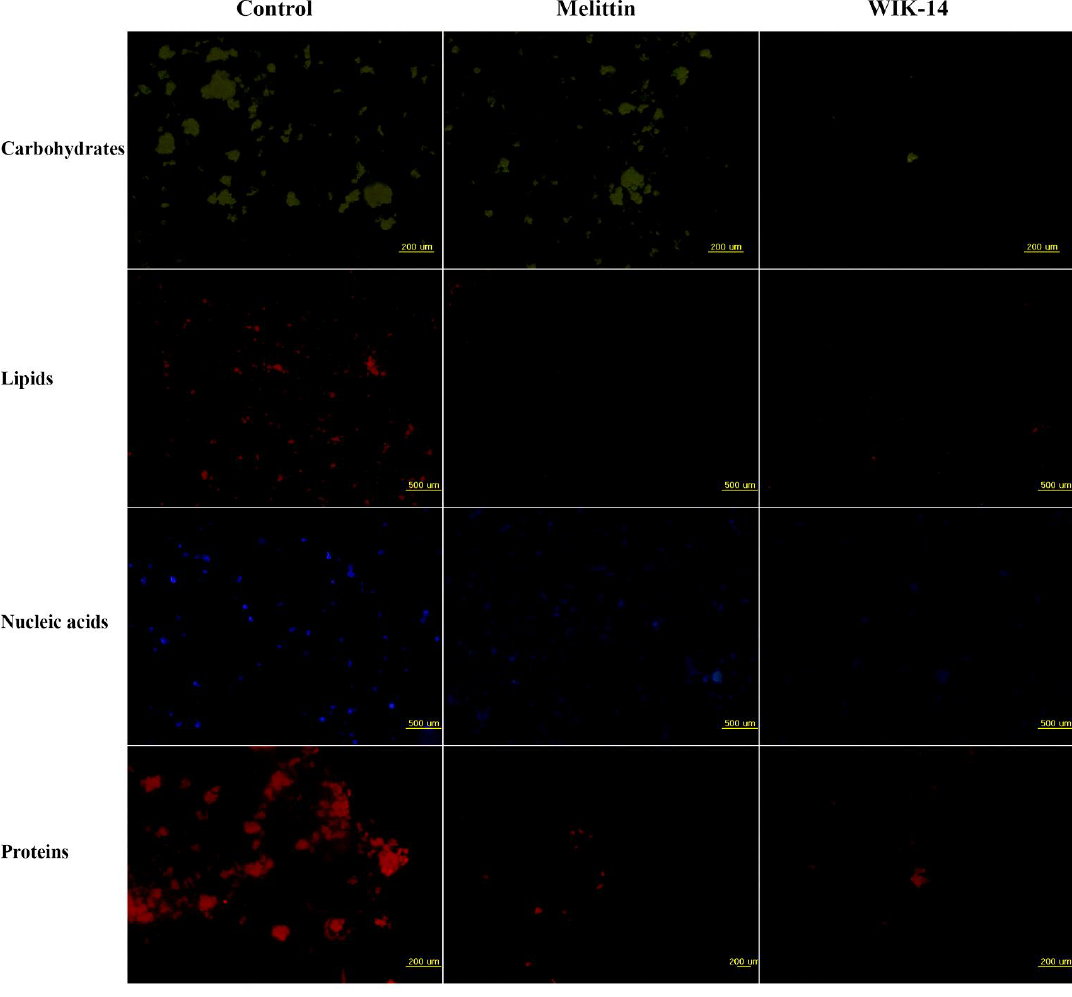
Figure 4. Eliminative action of peptides in biofilm extracellular polymeric substances (EPS). Biofilm EPS of P. aeruginosa DRPa 4007 in the absence or presence of peptides (64 µM) was stained by FITC- ConA for carbohydrates, Nile red for lipids, DAPI for nucleic acids, and SYPRO red for proteins and observed under fluorescence microscopy.